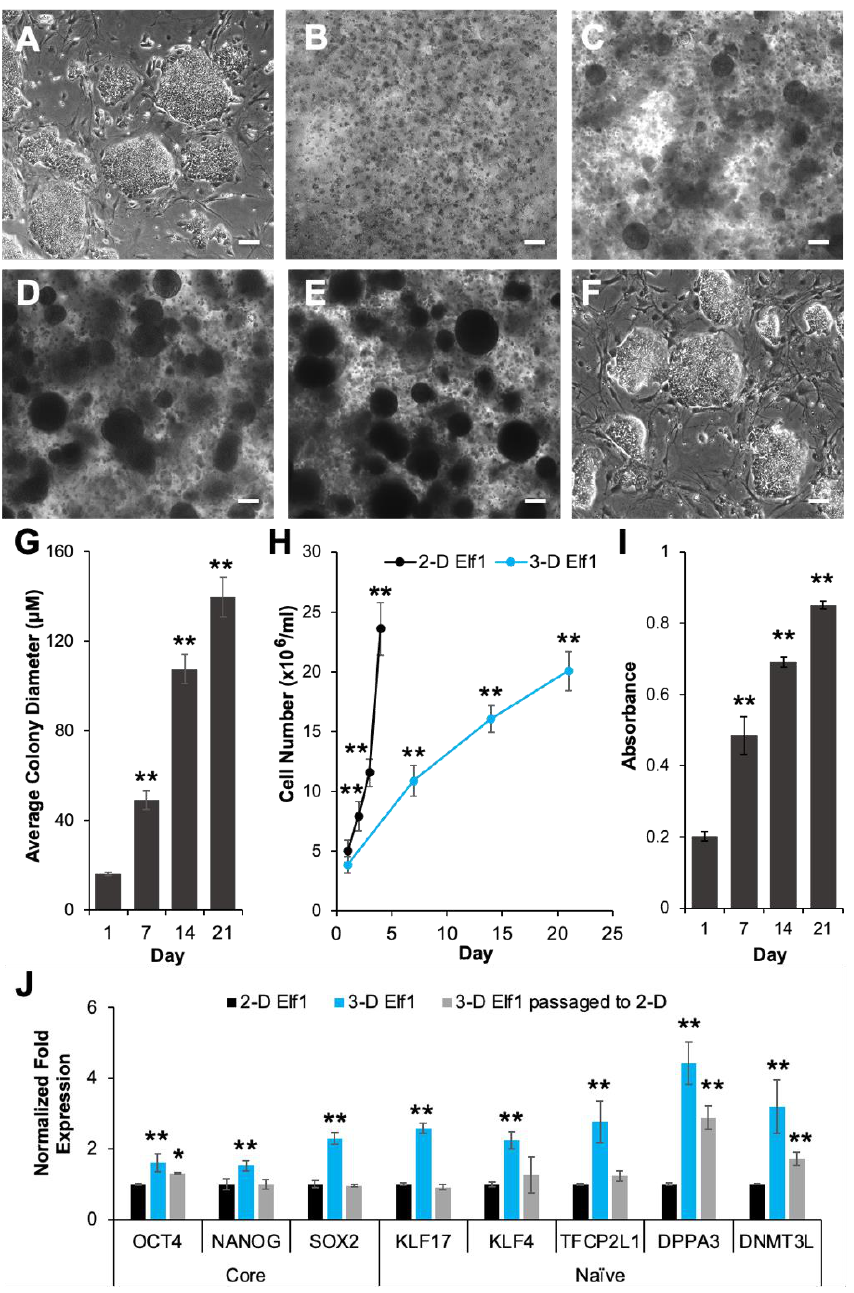
Figure 2. Comparison of naïve ESCs grown in 2-D and 3-D culture conditions. ( A ) Light micrographs (LM)showing the morphology of naïve human ESCs (Elf1) cells grown in 2-D conditions, ( B – E ) LM showing the morphology of Elf1 cells grown in 3-D PEG-8-SH/PEG-8-Acr scaffolds for 0, 7, 14 and 21 days, respectively. ( F ) LM of Elf1 cells grown in 3-D and then subcultured back to 2-D culture conditions displayed undifferentiated morphology and clonal growth comparable to the initial 2-D grown cells. All scale bars represent 100 µ m. ( G ) Quantification of colony size of Elf1 cells grown in 3-D scaffolds was determined using ImageJ software and expressed as average diameter ( µ m) ± SEM. ( H ) Growth of Elf1 cells in 2-D and 3-D culture conditions was assayed by direct counts at various time points using a hemocytometer. Data are presented as cell number ( × 10 6 cells/mL) ± SEM. ( I ) Quantitative determination of ESC proliferation by MTT assay. Results were expressed as the absorbance ± SEM with a significant increase in cell number. ( J ) Expression of core and naïve pluripotency markers in Elf1 cells grown in 2-D and 3-D culture conditions as well as 3-D grown cells passaged to 2-D culture as determined by qRT–PCR. Results were expressed as the fold expression ± SEM normalized to reference genes HMBS and GAPDH (* p ≤ 0.05 and ** p ≤